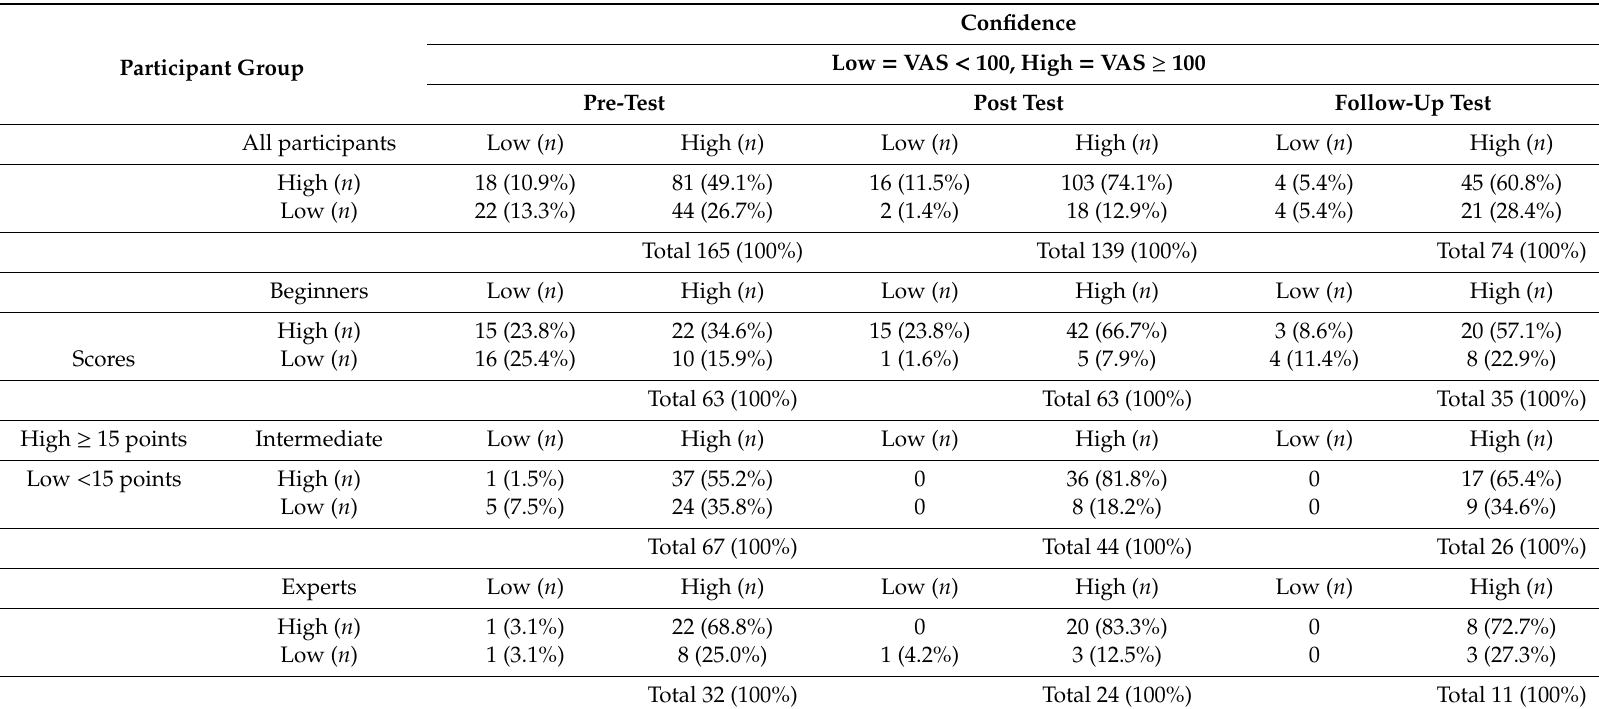
Table 3. Confidence in answers in all three tests, stratified according to clinical